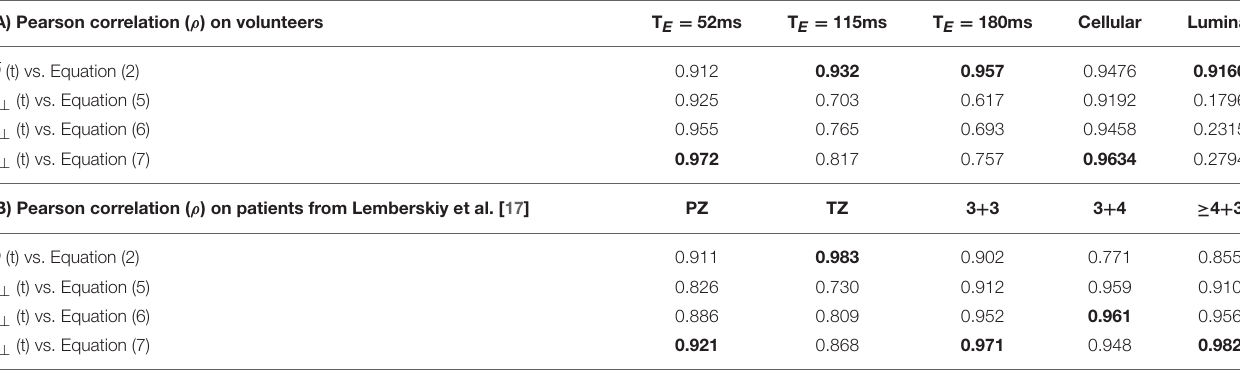
TABLE 2 | Pearson correlation coefficient, ρ , is used as a proxy for model selection at various echo time ( T E ) and at separated cellular/luminal diffusion tensors. (A) Pearson correlation ( ρ ) on volunteers T E = 52ms T E = 115ms T E = 180ms Cellular Luminal 0.912 0.932 0.957 0.9476 0.9160 0.925